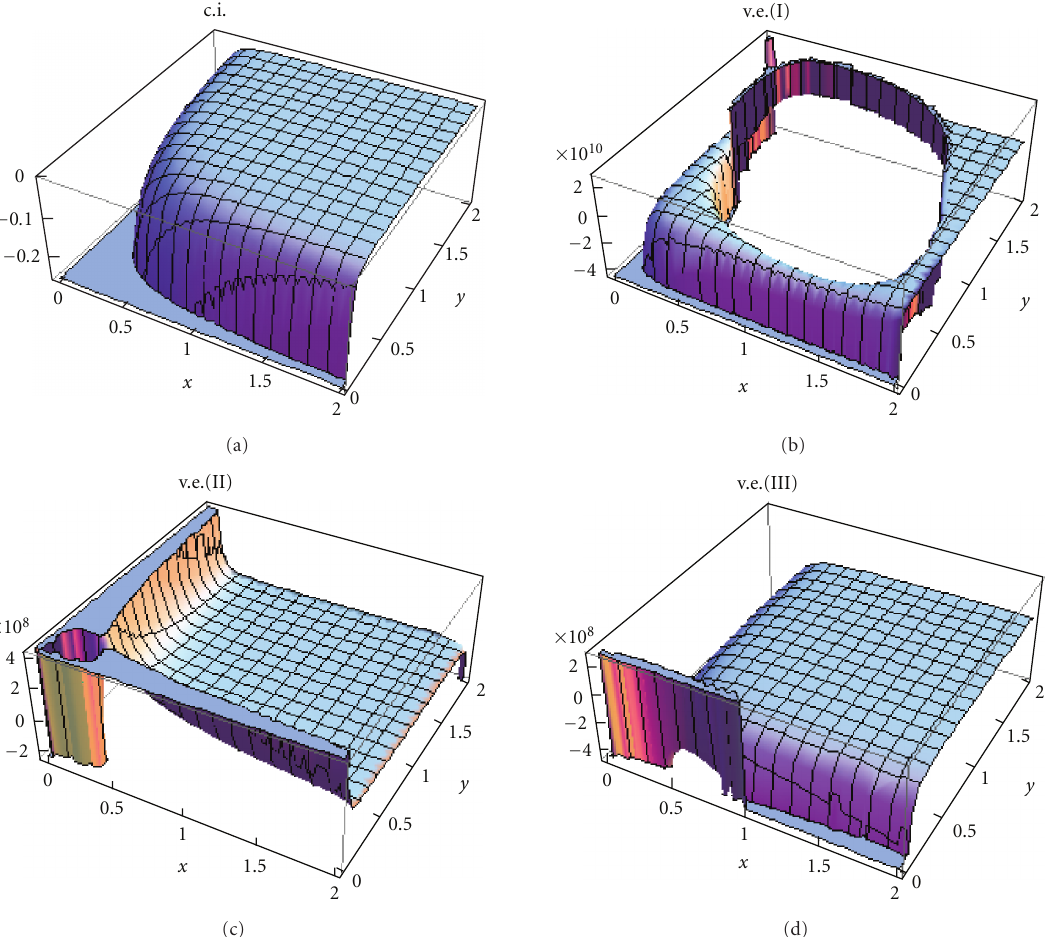
Figure 6: Plots of the contact interaction and of the vector-exchange contributions in the specialized planar configuration (minus sign).